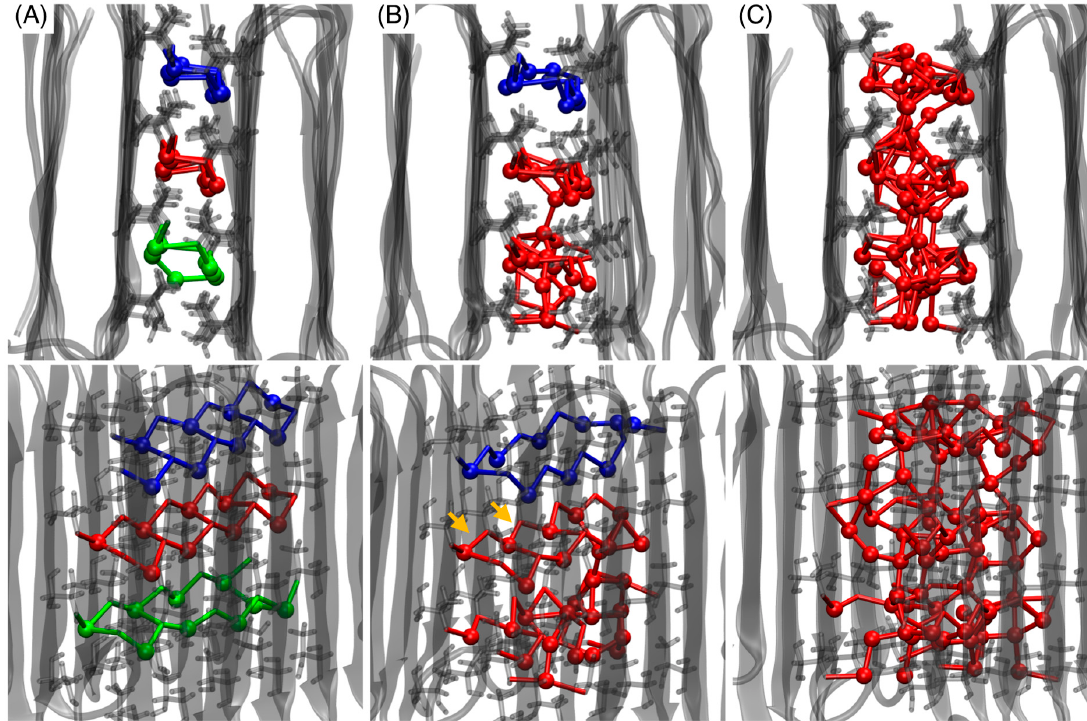
Figure 4. Characteristic instantaneous structures comprising water molecules and OH groups in the interprotein region, observed at ( A ) d = 1.52, ( B ) 1.70, and ( C ) 1.86 nm during the dissociation. These d s correspond to the first minimum, first barrier, and second minimum in the PMF. At each d , two views from different angles are shown. The water molecule and the OH groups are connected by lines if their oxygen–oxygen distance is shorter than 0.34 nm, which is the first minimum of the oxygen–oxygen radial distribution function for bulk water [48]. Water molecules are represented by balls. The transparent gray shapes show proteins in cartoon representation and the sticks represent Thr residues on the ice-binding surfaces (IBSs). The orange arrows in panel B indicate the remaining hexamers.